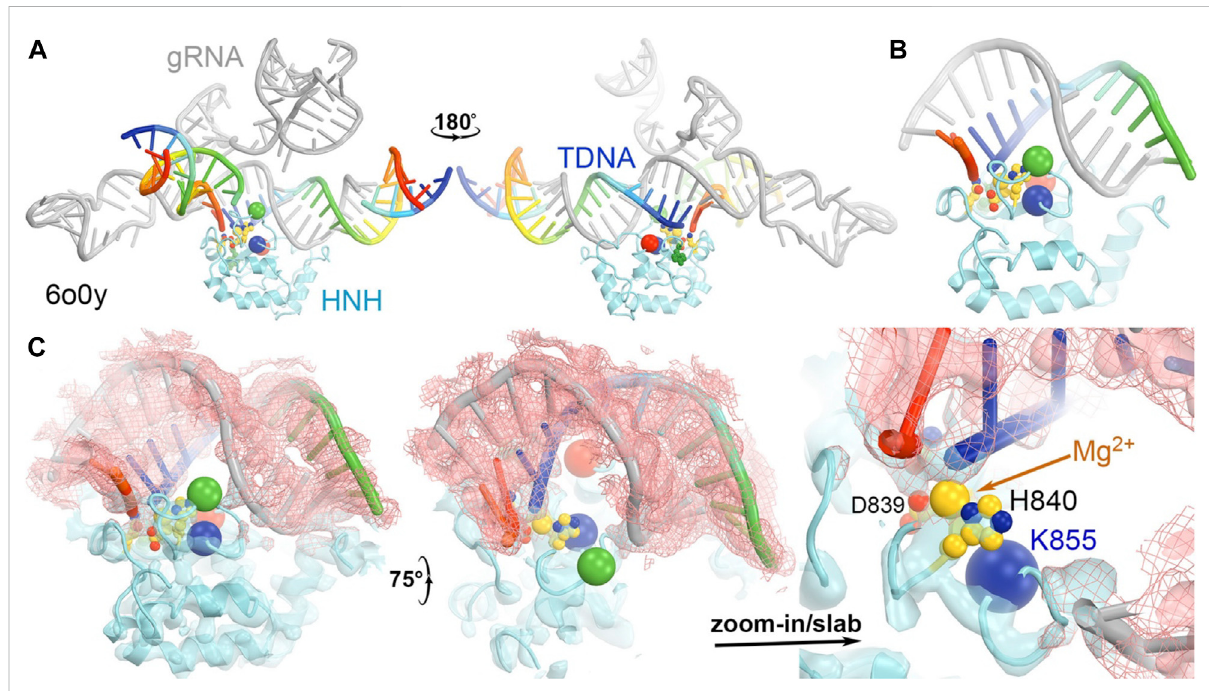
FIGURE 8 (A) Two front and back views of the HNH domain from the HNH-activated Cas9 complex of 6o0y. (B) Close-up view of the HNH binding at the minor groove of the RNA/DNA duplex. (C) Three views of the complex superposed with emd-0584 contoured at 6 σ (cyan isosurface and salmon isomesh) and 12 σ (salmon